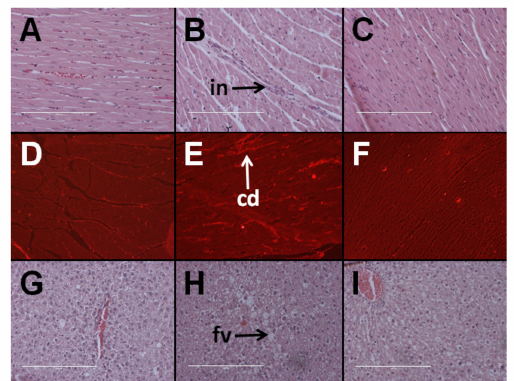
Figure 1. Effects of Kappaphycus on inflammation (top row—“in”) and collagen deposition (middle row—“cd”) in the heart using hematoxylin and eosin stain and picrosirius red stain, respectively, in C rats ( A , D ), H rats ( B , E ), and HR rats ( C , F ). Effects of Kappaphycus on inflammation and fat deposition (bottom row—“fv”) in the liver using hematoxylin and eosin stain in C rats ( G ), H rats ( H ), and HR rats ( I